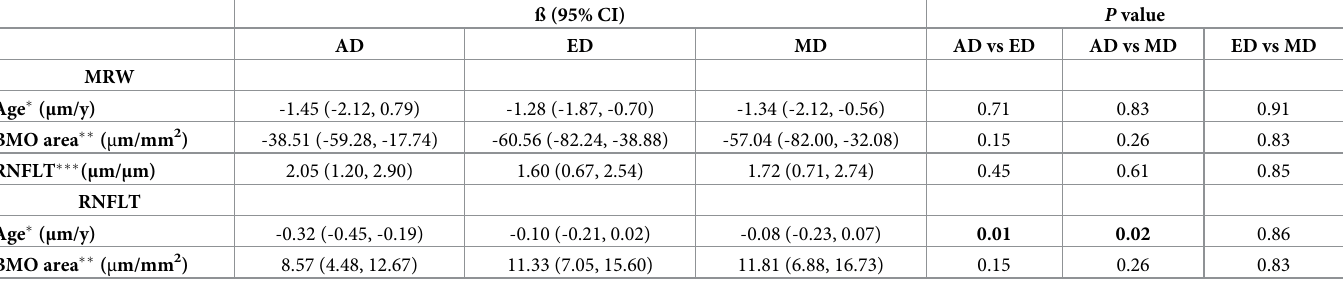
Global MRW declined significantly with age, after adjusting for BMO area, in AD (-1.45 μ m/year; P < 0.01 versus 0), the amount by which was not different in ED (-1.28 μ m/ in ED and MD (P = 0.91; Table 4 ). The age-related reduction of global RNFLT, adjusted for BMO area, was significant in AD (-0.32 μ m/year; P < 0.01 versus 0) and was faster than that compared to ED (-0.10 μ m/year, P = 0.01) or MD (-0.08 μ m/y, P = 0.02). The rate of global RNFLT reduction with age was similar in ED and MD (P = 0.86; Table 4 and Fig 4 ). After adjusting for age, global MRW declined significantly with BMO area in AD